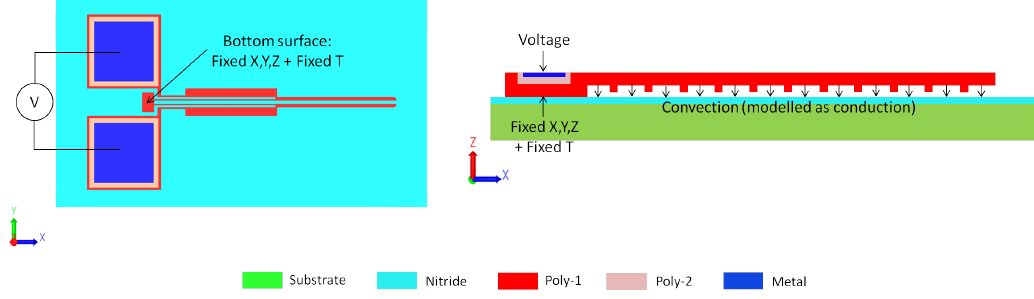
Figure 3. The suspended PolyMUMPs TM electrothermal microgripper as modelled in CoventorWare R (cid:13) . This model represents the mechanical structure for Design Variants 1-3, and demonstrates the boundary conditions applied to the model.